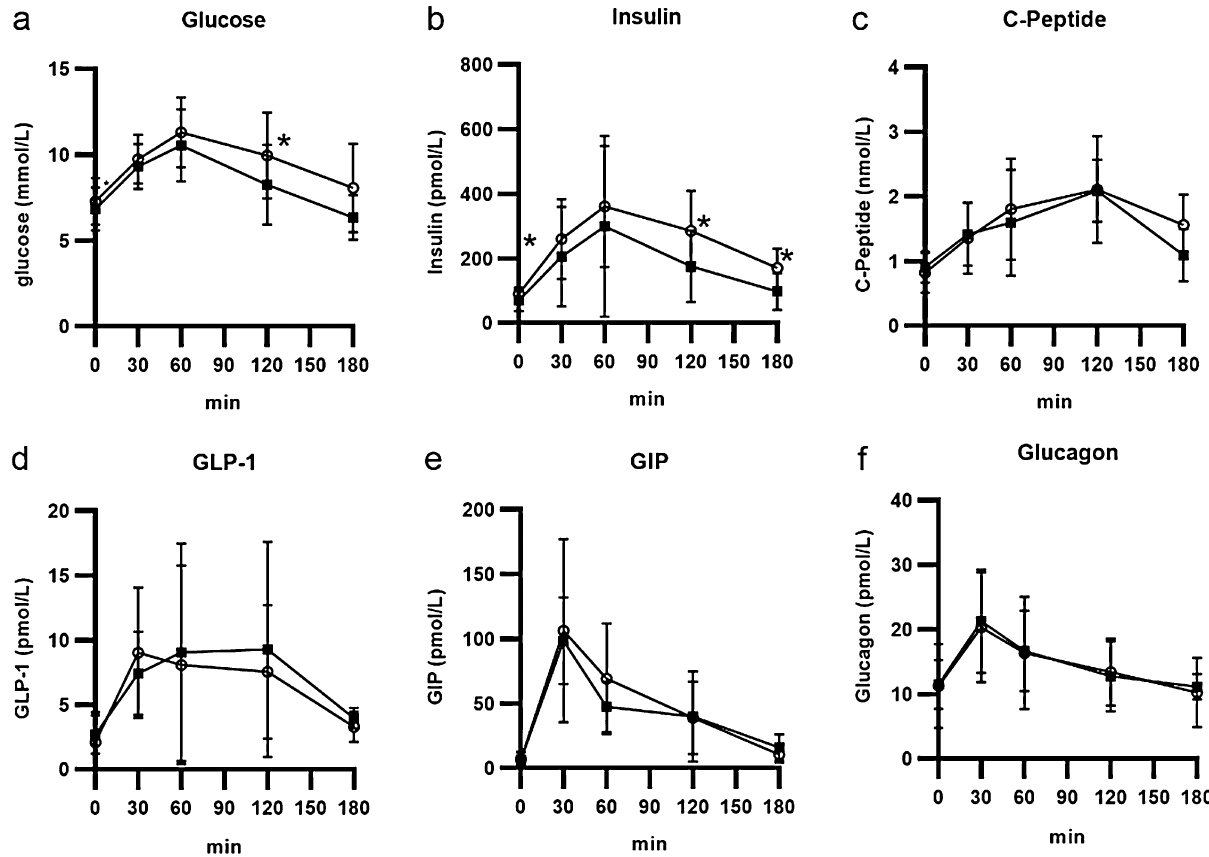
Figure 1. MTT Results. ( a ) shows glucose levels after the MTT, and ( b ) insulin, ( c ) C-peptide, ( d ) GLP-1, ( e ) GIP, and ( f ) glucagon levels are also shown. The white circles represent the pretreatment data, and the black squares indicate the posttreatment data. *, p <